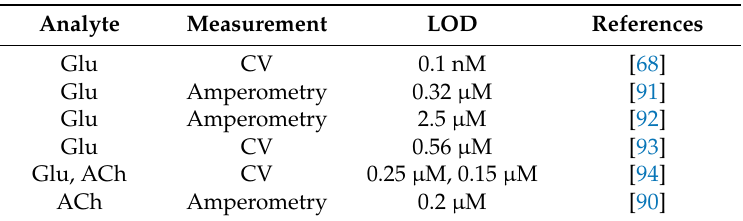
Table 4. Enzyme-based neurotransmitter